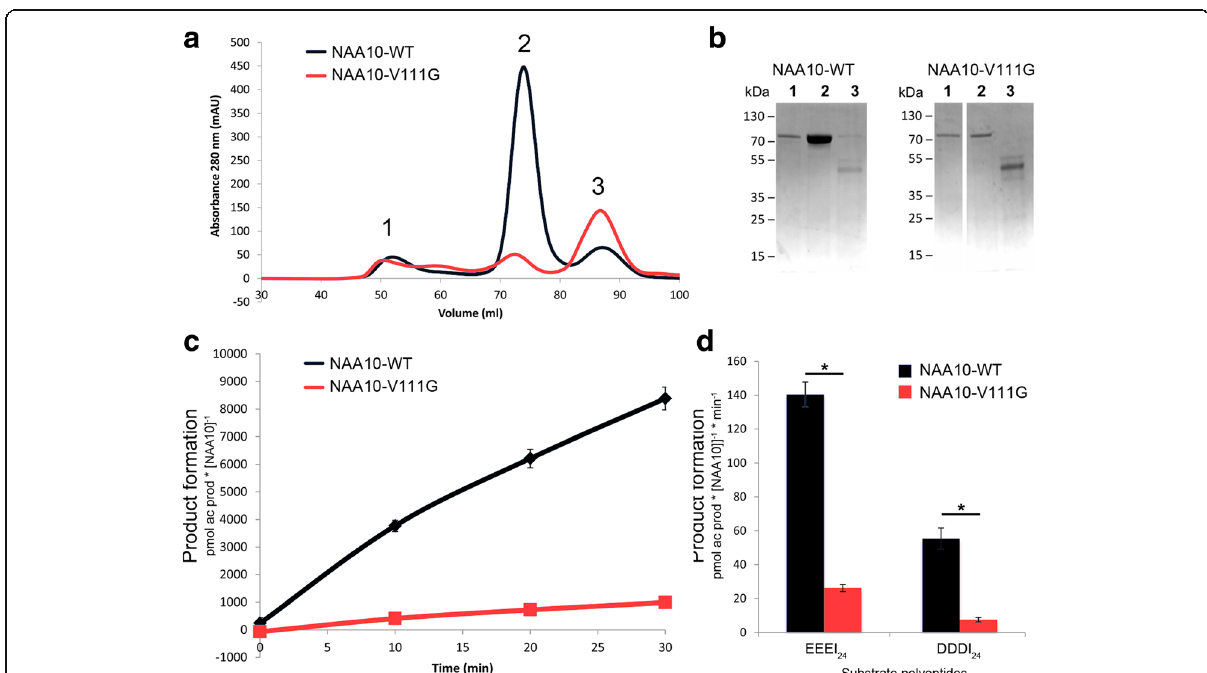
Fig. 2 Protein purification and in vitro N-terminal acetyltransferase assays ( a ). Size exclusion chromatography of His/MBP-NAA10-V111G and His/ MBP-NAA10-WT. Both the void volume (peak 1), and the monomeric peak at approximately 74 ml (peak 2) contain His/MBP-NAA10-WT or His/ MBP-NAA10-V111G. The peaks corresponding to monomeric NAA10 (approximately at 75 mL) was further used for enzymatic experiments. b All fractions were analyzed by SDS-PAGE. c Time dependent Nt-acetylation of the substrate peptide EEEI 24 catalyzed by His/MBP-NAA10-WT and His/ MBP-NAA10-V111G. d Nt-acetylation of substrate peptides EEEI 24 and DDDI 24 catalyzed by His/MBP-NAA10-WT and His/MBP-NAA10-V111G. * statistically significant ( p < 0.0001, student